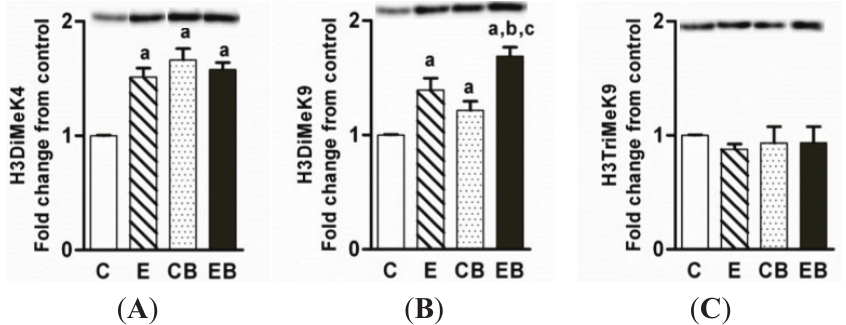
Figure 4. Levels of dimethylated H3K4, dimethylated histone H3K9, and